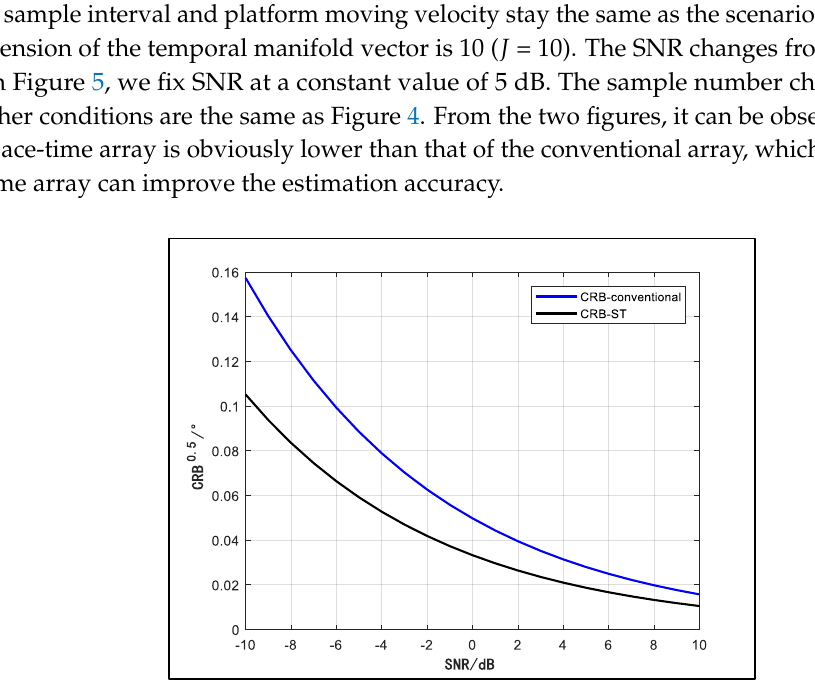
Figure 3. CRB of signal direction estimation versus SNR.